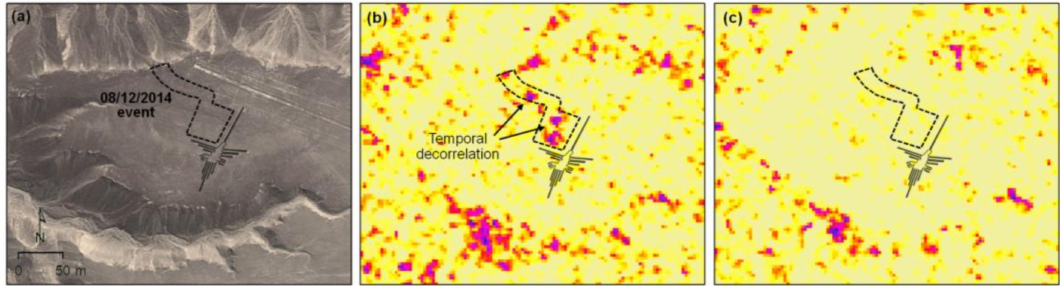
Figure 6. ( a ) Google Earth overview of the plateau where the Hummingbird geoglyph is carved (VHR image © 2018 DigitalGlobe), with a sketch of the geoglyph and indication of the area affected by the 08/12/2014 incident as delineated in [31]; and ( b , c ) InSAR coherence γ for two COSMO-SkyMed StripMap pairs: ( b ) 10/07/2014–12/04/2015 (cross-event) and ( c ) 13/12/2017–30/01/2018